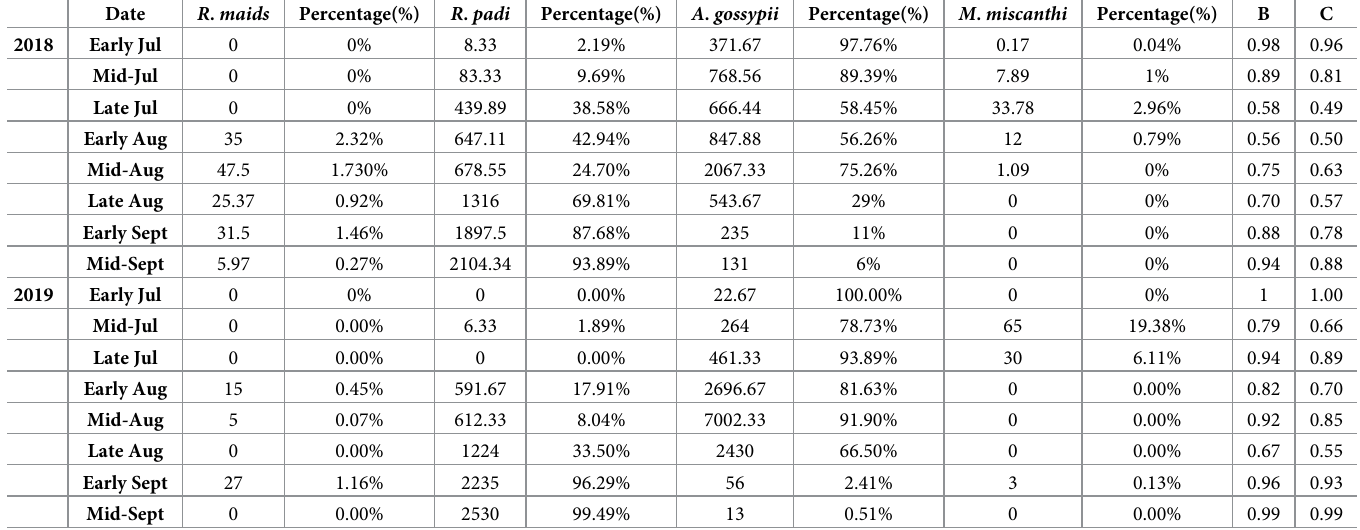
Table 4. The population dynamics and dominance of aphids in Gongzhuling area maize field in 2018 and